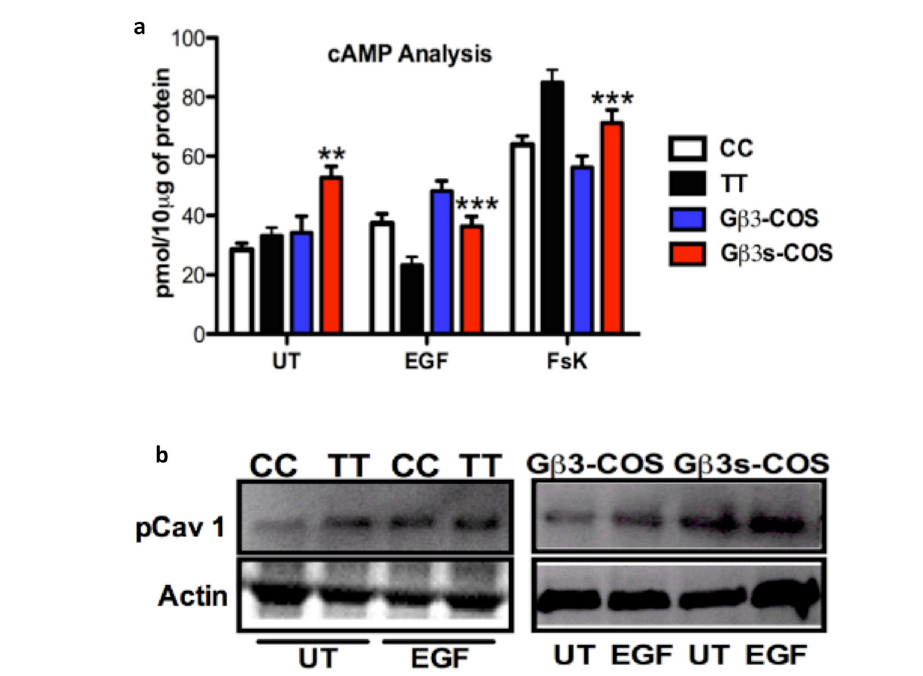
Figure 4. Lack of cAMP induces caveolar-1a phosphorylation. cAMP analysis was measured in CC and TT lymphoblast protein lysates obtained from either untreated cells, or following treatments with EGF or Forskolin (Fsk) as mentioned in methods (a). Decrease in cAMP generation upon EGF stimulation in TT lymphoblast leads to increased phosphorylation of Cav -1a when compared to CC lymphoblast cells (b). Similar trend in cav-1a phosphorylation kinetics was observed in COS-7 stable clones. Data are the mean with standard error (bars) of n=3 independent experiments. Statistical significance is shown as *P<0.05, **P<0.01,